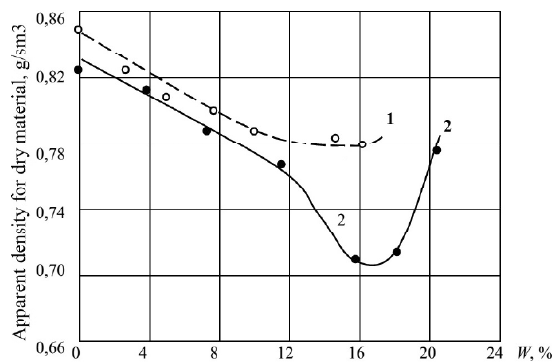
Fig. 6. Dependence of the apparent density of the powder, obtained by spray drying of ceramic slurry, on humidity W when measuring with funnel (1) and gutter (2).